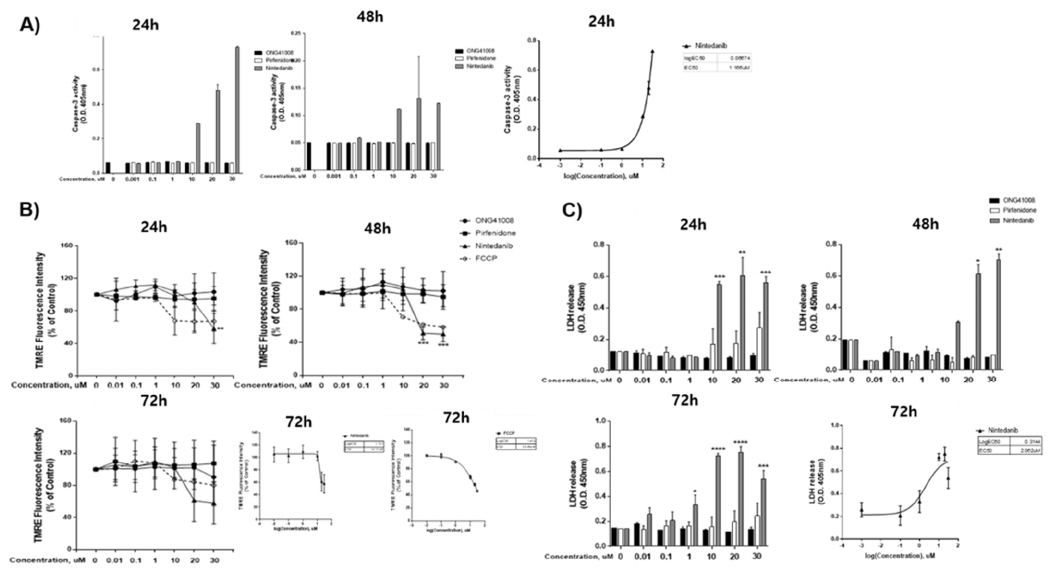
Figure 2. ONG41008 did not induce apoptosis in DHLFs. DHLFs were stimulated with ONG41008, pirfenidone, or nintedanib. (A) An activated caspase ‐ 3 assay was performed, and the EC50 value of nintedanib was calculated at 24 h. (B) The mitochondrial membrane potential was measured. The mitochondrial oxidative phosphorylation uncoupler FCCP was used as a control. The IC50 values of nintedanib and FCCP were calculated at 72 h. (C) Lactate dehydrogenase (LDH) levels were assayed. The EC50 value was calculated with a sigmoidal, four ‐ parameter logistic in GraphPad Prism, version 7.00. At least three independent measurements were conducted. Standard deviations are represented by the bars. In Supplementary Materials Video S1, 6 day live imaging clearly demonstrates the difference between ONG41008 and nintedanib. (* p < 0.01, ** p < 0.001, and *** p < 0.0001).